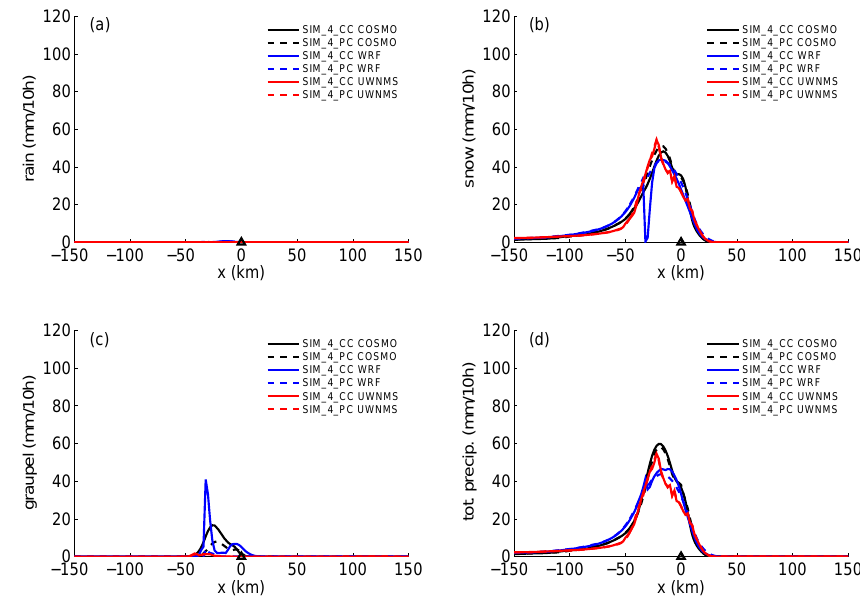
Fig. 18. Same as Fig. 9 but for simulation SIM 4 CC (solid) and SIM 4 PC (dashed).